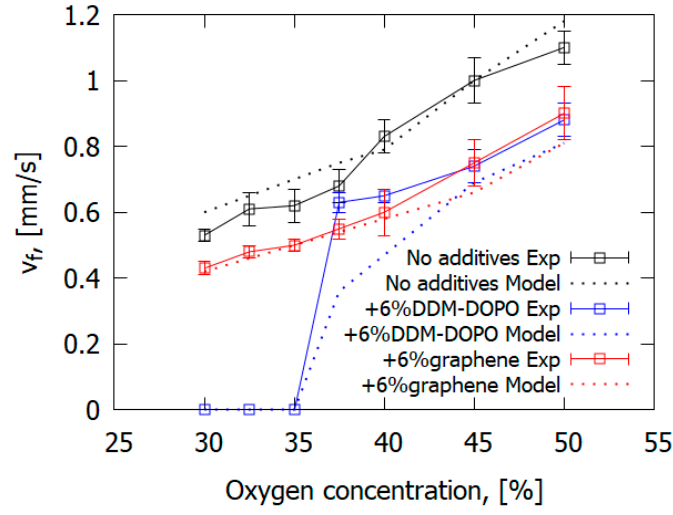
Figure 25. The measured and simulated dependences of the ROS on the O 2 concentration for downward flame spread over GFRER slabs. Table 6. The rate of flame spread (mm/s) over fiberglass-reinforced composites. The values in paren- theses indicate the maximum surface temperature in the model and experiment in the flame